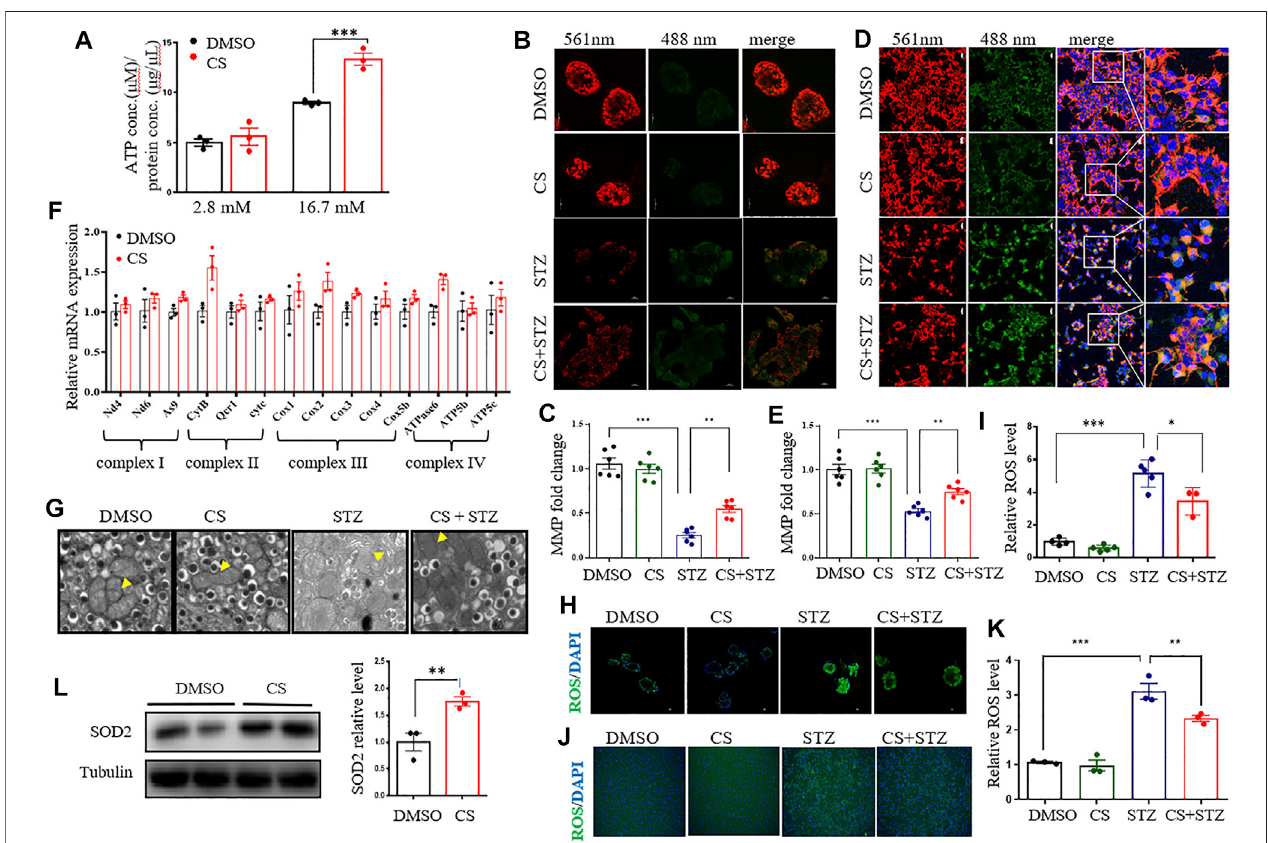
FIGURE 6 | CS restores mitochondrial function of islets under stressful condition. (A) Total cellular ATP concentration in isolated islets was determined following a 20-minincubationwithglucoseattheconcentrationof2.8 mMor16.7 mM. (B – E) Mitochondrialmembranepotential(MMP)wasassayedinmouseislets (B,C) orINS-1 β -cells (D,E) aftera6-hpreincubationof10 µMCSorDMSOfollowedbyacoincubationofCS(10 µM)andSTZ(2.5 mM)for12 h.JC-1sendsredorgreen fl uorescence when MMP is high in the normal mitochondria or low in the unhealthy mitochondria, respectively. Representative images were taken at emission 488 nm (green- indicating JC-1 monomers in the cytoplasm) and at 561 nm (red-indicating JC-1 polymers in the mitochondrial matrix). (F) Relative mRNA expressions of genes encoding mitochondrial respiration complex factors in INS-1 β -cells treated with DMSO or 10 µM CS for 12 h. Individual measurement was normalized to 18s rRNA expression,andtheDMSO-treatedcontrolaveragewassetto1. (G) Mouseisletssectionswereexaminedbytransmissionelectronmicroscope(TEM)(scalebar:1 µm). Theyellowtrianglesindicateswollenmitochondriaaroundthenucleus. (H – K) EffectsofCSonSTZ-inducedreactiveoxygenspecies(ROS)inmouseislets (H,I) andINS- 1 β -cells (J,K). Mouse islets or INS-1 β -cells were incubated with 10 µM CS for 6 h followed by a 12-h incubation with 2.5 mM STZ. ROS was measured with a ROS assay kit. The fl uorescence signal was monitored with a 448-nm excitation fi lter and fl uorescence intensity was quanti fi ed. (L) The protein levels of SOD2